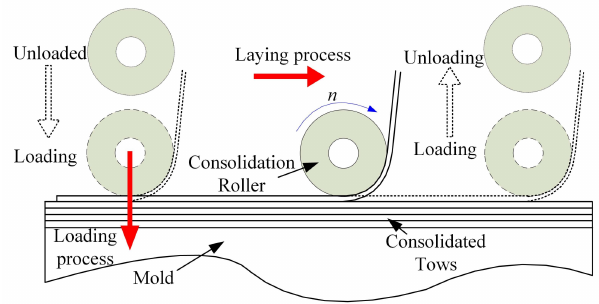
Figure 11. The laying process of the last tow.